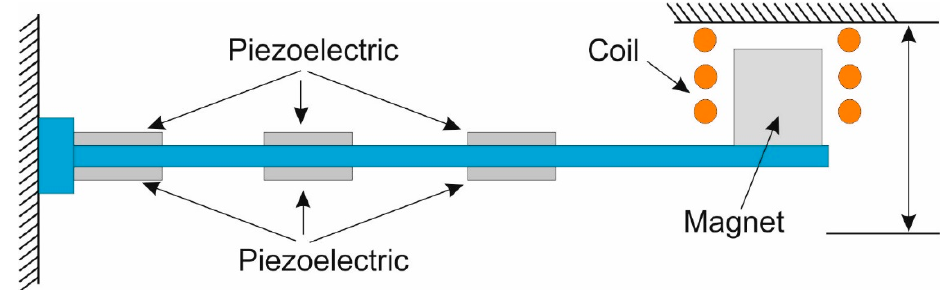
Figure 12. A hybrid EH generator exploiting the piezoelectric and electromagnetic effects.